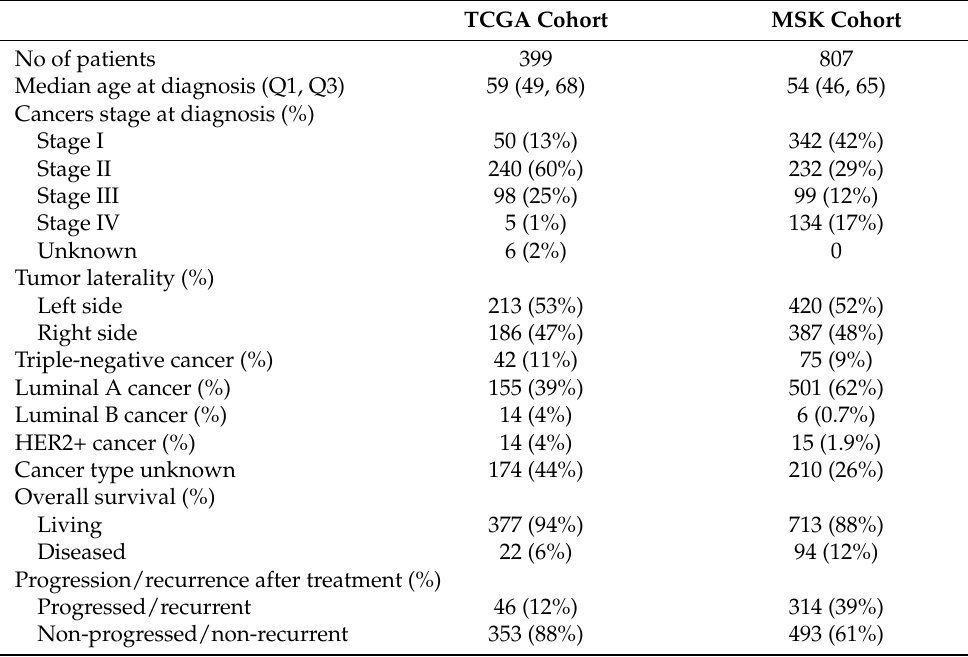
Table 1. Clinical characteristics of BC patients from TCGA and MSK